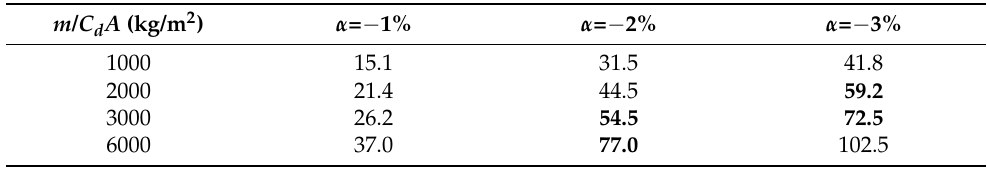
Table 1. Coasting speeds (mph) with respect to different declines and ratios of m / C d A for the second truck in a platoon.